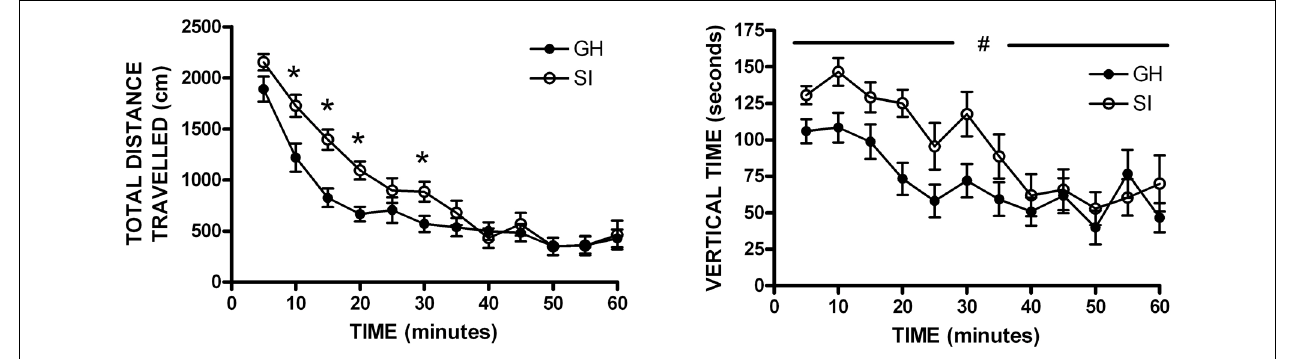
FIGURE 2 | Open field locomotor activity. Socially isolated (SI) rats showed significantly more locomotor activity [distance traveled; group × time F (11,407) = 2.955, * p < 0.001] and spent more time